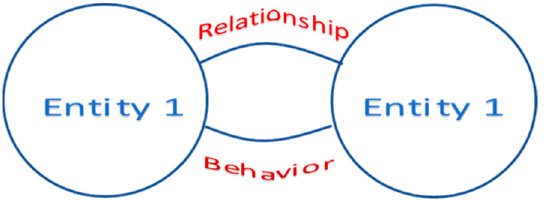
Figure 2. The fundamental triad (also known as named set) as a knowledge structure derived from information.